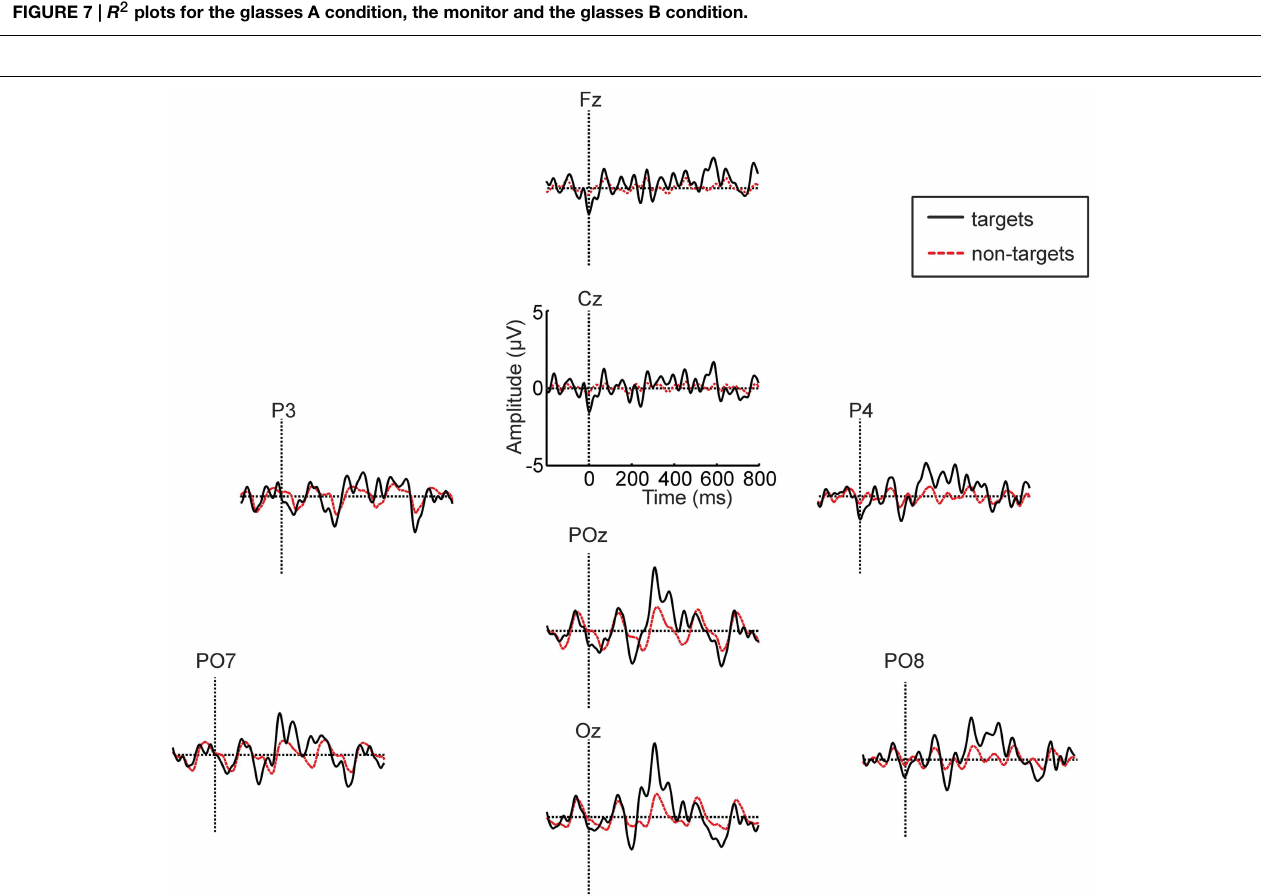
FIGURE 8 | Averaged ERP waveforms for the participant with LIS in session 3 (glasses A condition). The data of the copy spelling and the two free spelling runs were combined for the